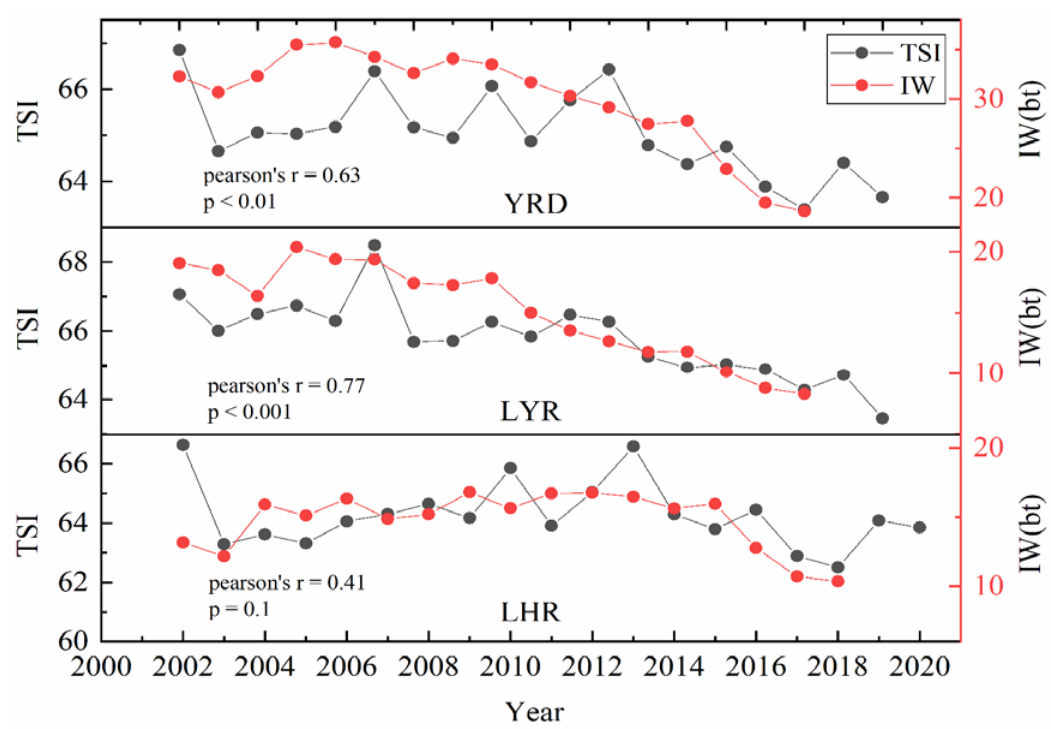
Figure 15. Long-term variations in TSI and industrial wastewater in the YRD, LYR, and LHR from 2002 to 2020.